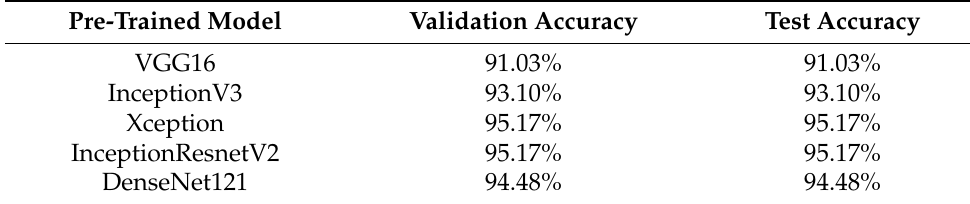
Table 4. Pre-trained model results with data augmentation.